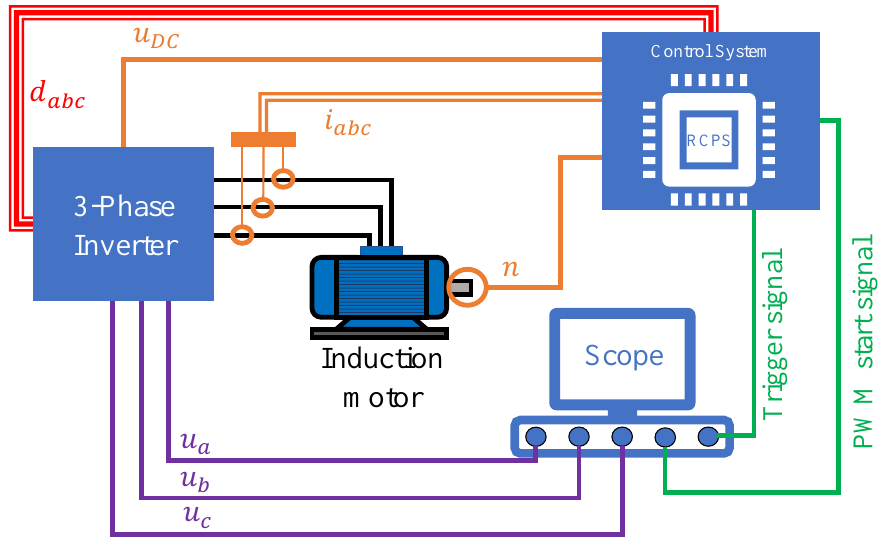
Figure 3. Measurement